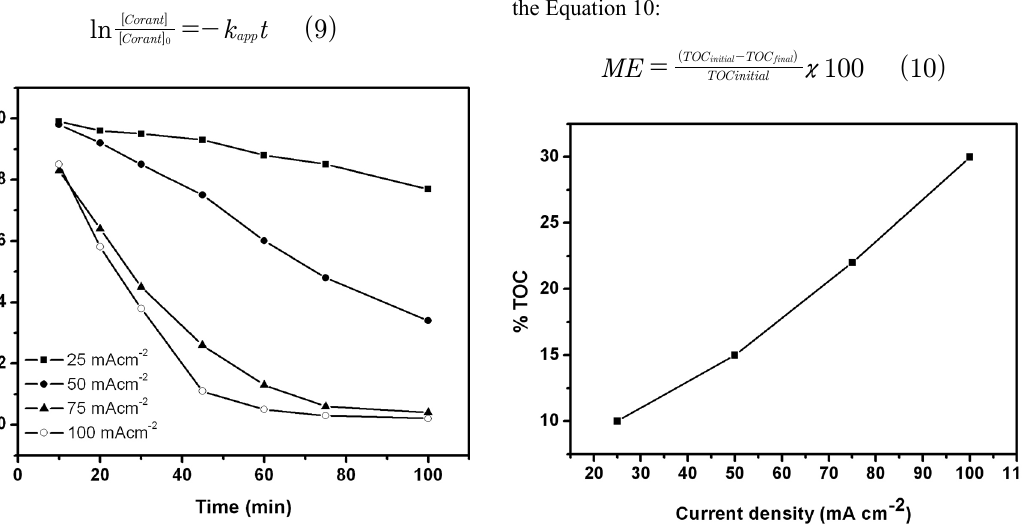
Figure 9. TOC removal efficiency as a function of the applied current densities during the electrodegradation